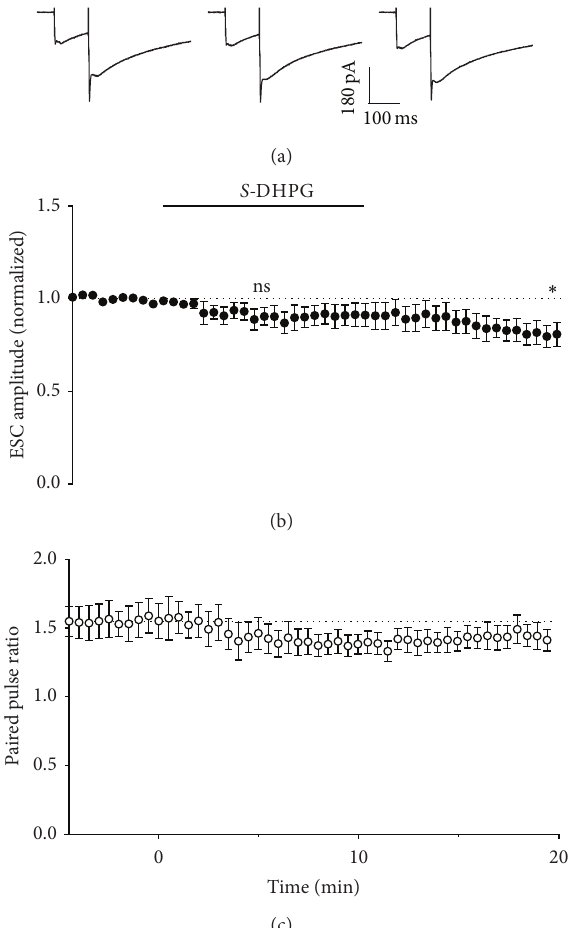
Figure 7: Effect of activation of mGluR1 on Bergmann glial responses. (a) Representative whole-cell recordings ESCs generated by paired pulse stimulation (100ms interval) of parallel fibres in transverse cerebellar slices at 0.033 Hz before (first panel), after 5 minutes incubation with 30 𝜇 M DHPG (second panel), and after 10 minutes of washout (third panel). (b) Time course of 30 𝜇 M DHPG effect on amplitude of the first pulse in each pair, with DHPG incubation at the time indicated by the bar. Data are mean ± s.e.m. from 7 cells. ∗ 𝑃 = 0.0214 , one-sample 𝑡 -test. (c) Time course of 30 𝜇 M DHPG effect on paired pulse ratio, with DHPG incubation at the time indicated by the bar. Data are mean ± s.e.m. from 7